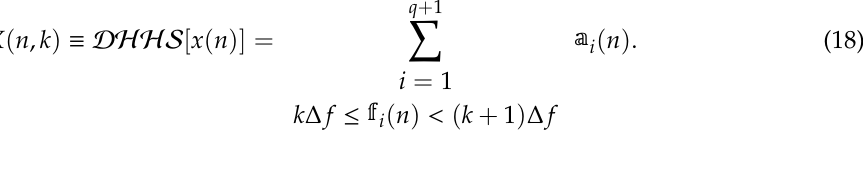
In these equations the residue is understood as the ( q + 1 ) -th IMF. This function, which is discrete in time but continuous in frequency and amplitude, is also known as the Hilbert–Huang Spectrum (HHS). To manage HHS as an ensemble of q + 1 pairs of vectors is often quite burdensome and leads to graphics that are not easy to read. To simplify its representation it is common to discretize the frequencies using a quantizing ∆ f step, building up a grid in the time–frequency plane. Then the amplitudes of all IMFs for every single grid spot are added, obtaining a Discrete Hilbert–Huang Spectrum (DHHS) defined